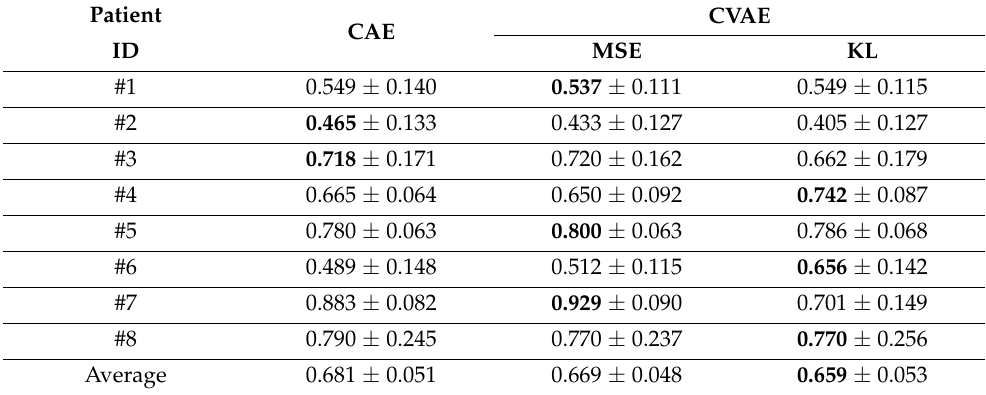
Table 13. Per-patient ROC AUC scores for the discrimination between sessions that correspond to stable, or anomalous, condition, for both CVAE and CAE personalized models. Patient